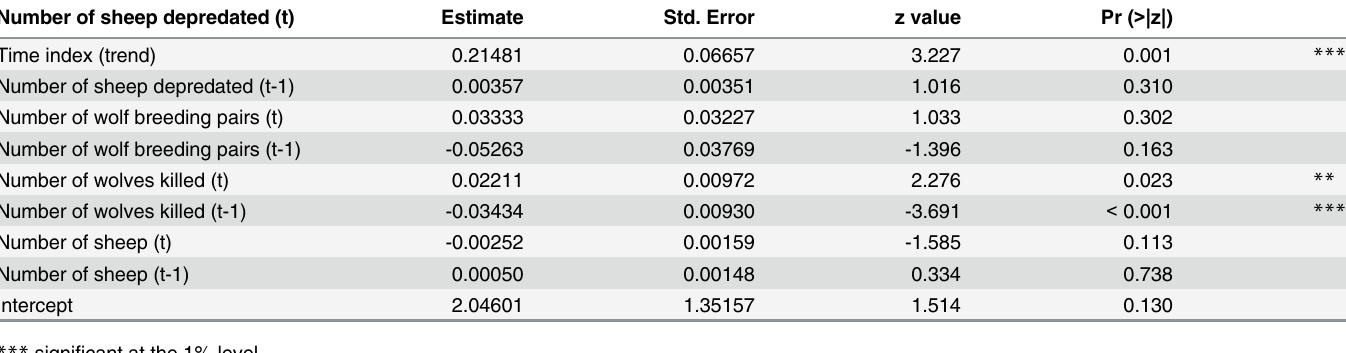
Table 2. Number of sheep depredated regressed on the number of wolves killed, number of wolf breeding pairs, number of sheep and time index. Number of sheep depredated (t) Estimate Std. Error Number of sheep depredated (t-1)